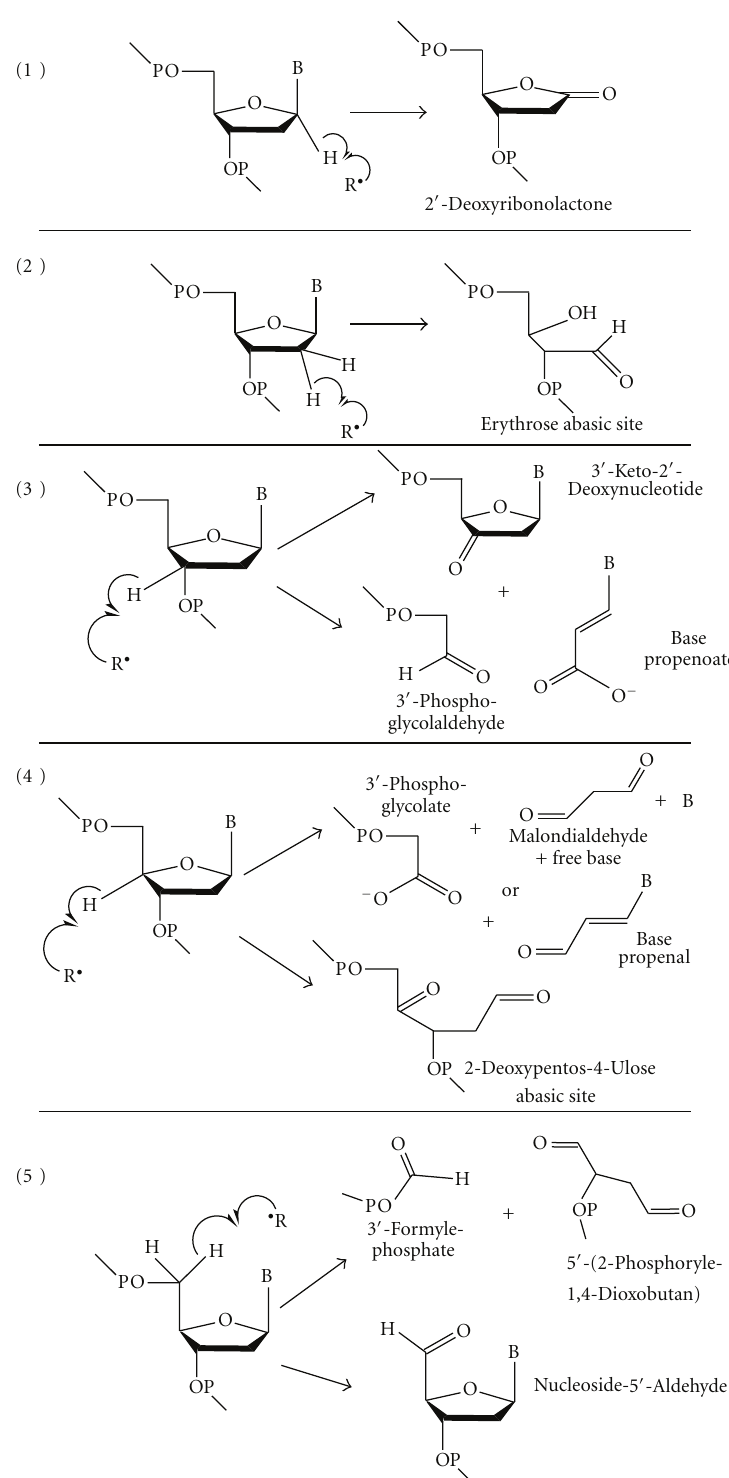
Figure 2: 2-Deoxyribose oxidation